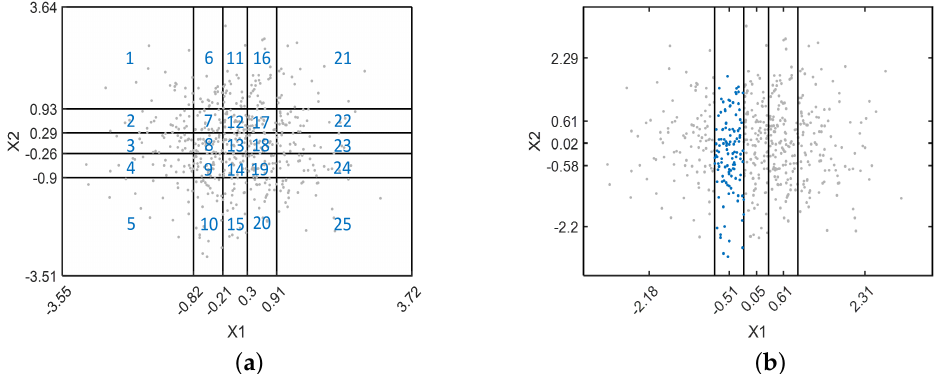
Figure 1. Data partitioning: Example of adaptive cell sizes for a bivariate Gaussian distribution. ( a ) Cells are defined by crossing grid lines in each orthogonal direction. ( b ) Only vertical grid lines are shown to highlight how data are binned into strips, and how the data within a strip are projected onto its